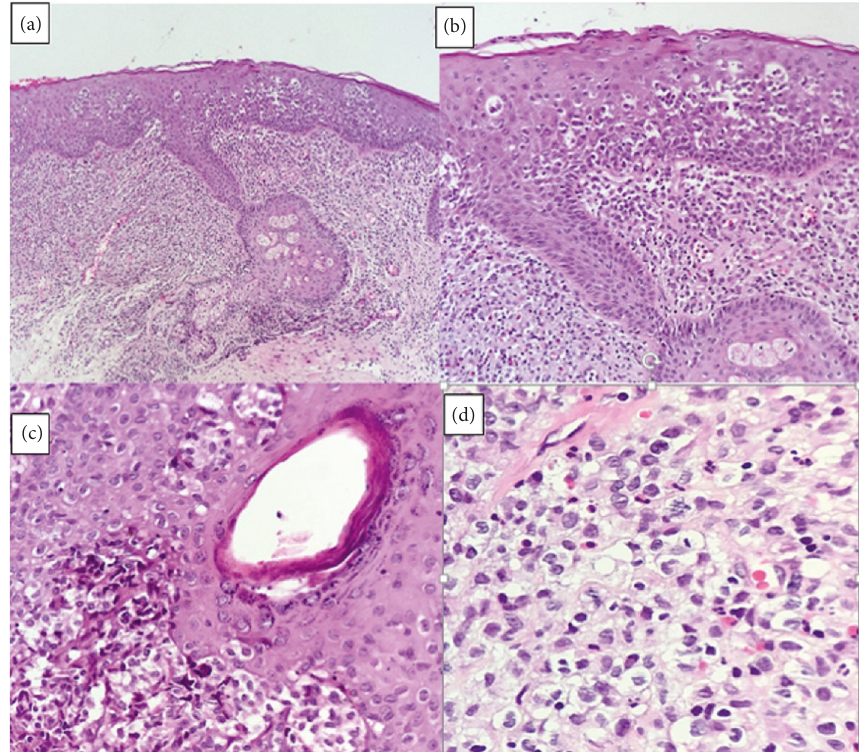
Figure 2: (a). There are some aggregates of Langerhans cells in the epidermal layer and diffuse upper and mid-dermal predominantly Langerhans cell infiltration (H&E × 100) (b). There are some aggregates of Langerhans cells in the epidermal layer and diffuse dermal predominantly Langerhans cell infiltration admixed with some eosinophils and few lymphocytes (H&E × 200) (c). Follicular epithelium involved by Langerhans cells (H&E × 400) (d). There is diffuse upper dermal predominantly Langerhans cell infiltration with mitotic figures admixed with some eosinophils and neutrophils and a few lymphocytes (H&E ×